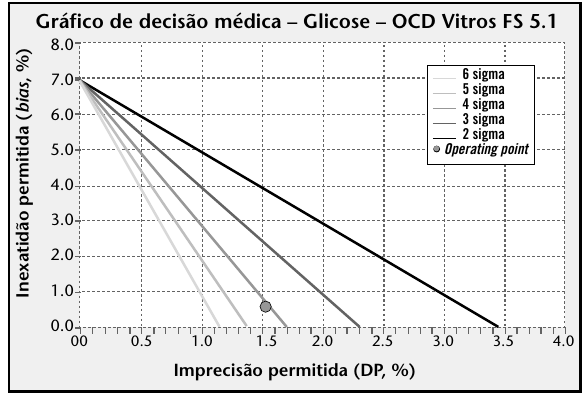
Figura 6 – Análise global de desempenho de longo prazo: gráfico de decisão médica, glicose Vitros FS 5.1, CV = 1,5%, ES = 0,6% – avaliação em métrica-sigma CV: coeficiente de variação; ES: erro sistemático; DP: desvio